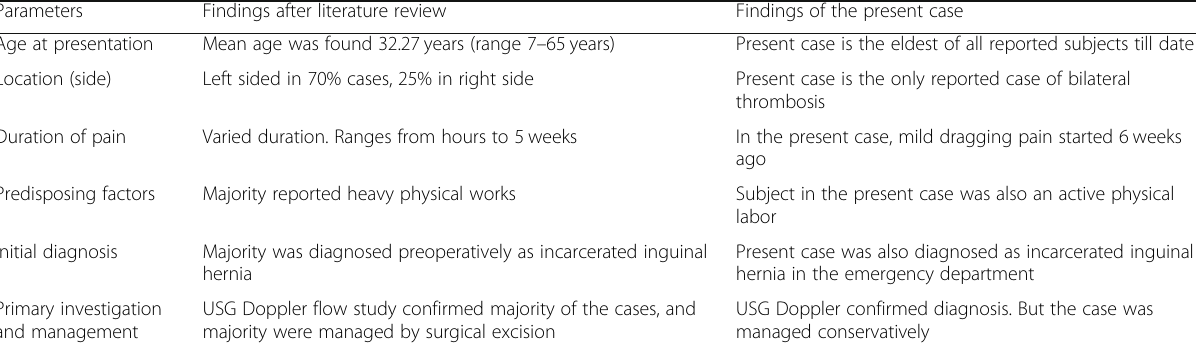
Table 2 Comparative characteistics of present study